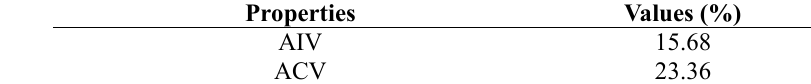
Strength resistance properties of burnt brick coarse aggregate.